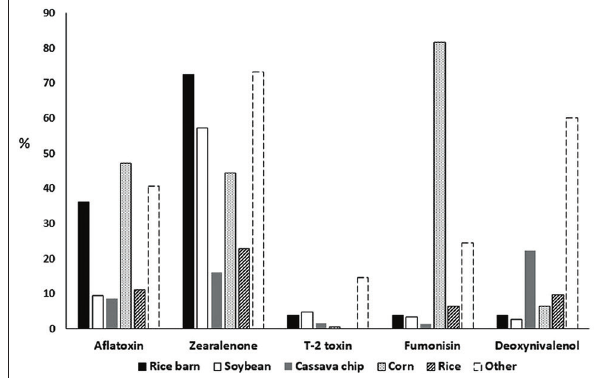
Figure-2: Percentage contamination as defined by feed ingredients (CS=Cassava chip, RI=Rice, RB=Rice bran, CO=Corn, SB=Soybean, Other=Ingredient identity not available).